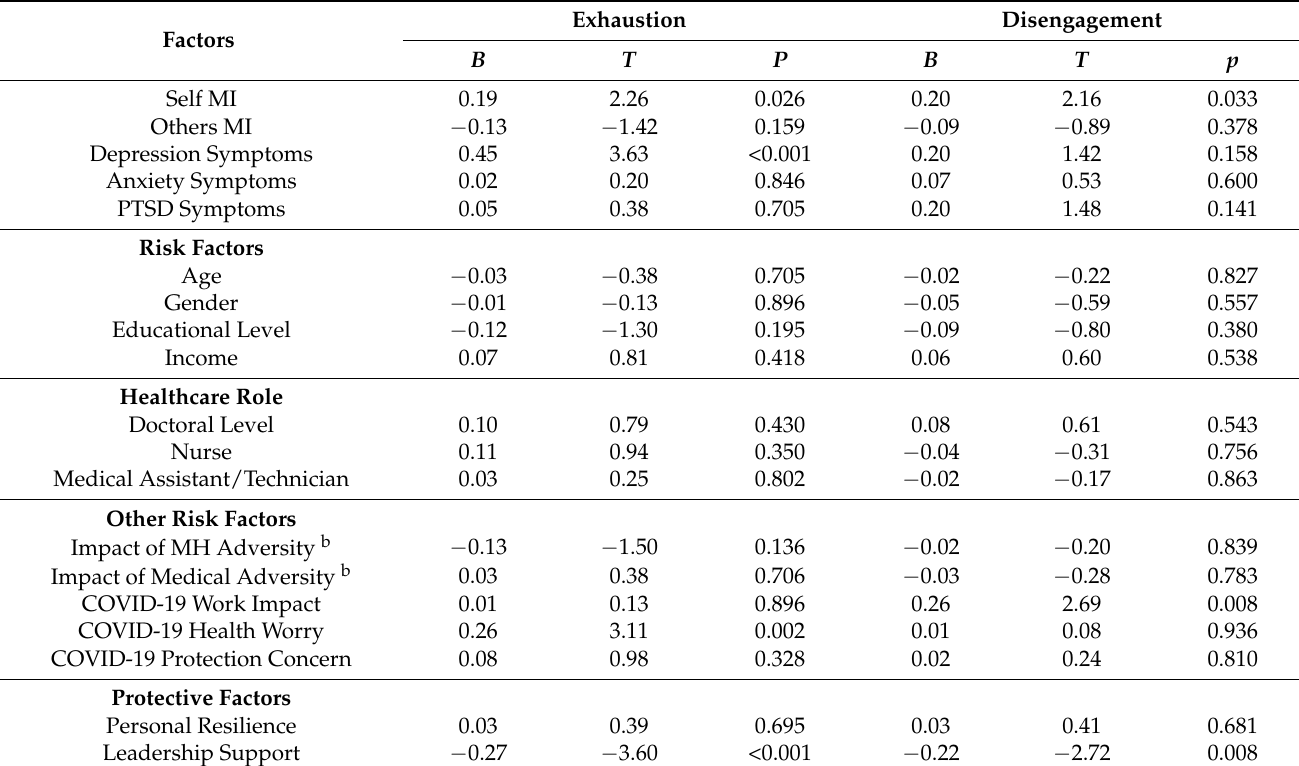
Table 4. Results of multilinear regression analyses predicting level of exhaustion and